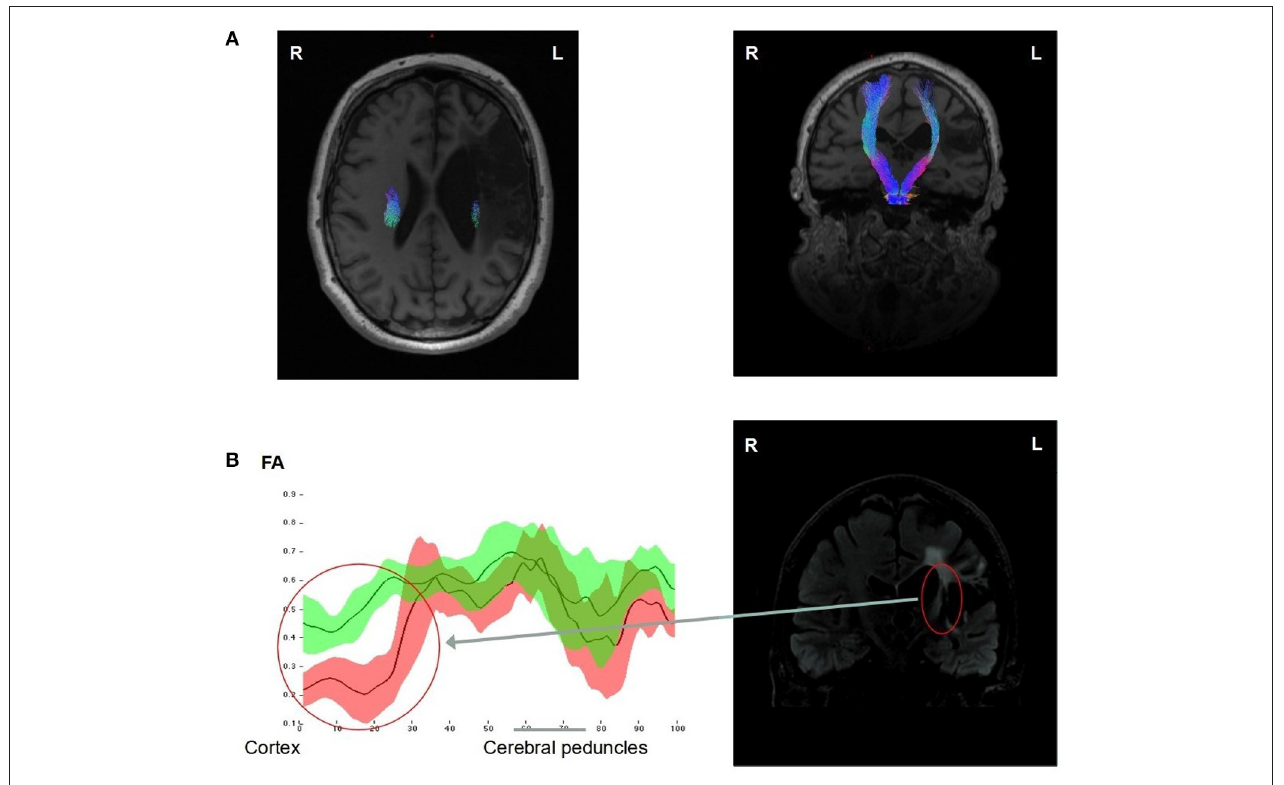
FIGURE 2 | DTI analysis of the corticospinal tracts (CST) of the patient 12 years after stroke onset. The CSTs of both hemispheres were reconstructed and represented in the axial and coronal T1w MRIs showing a reduction of the fiber numbers in the left CST compared to the right, particularly in its upper part, going between the ischemic lesion and the lateral ventricle (A) . FA measures (mean ± 1 SD) along both CST profiles, going from the up cortex to the down cerebral peduncles regions, showed a significant decrease ( > 2 SD) in the left (red) CST compared to the right (green) CST, in the upper part of the left CST (Red circle) (B) .